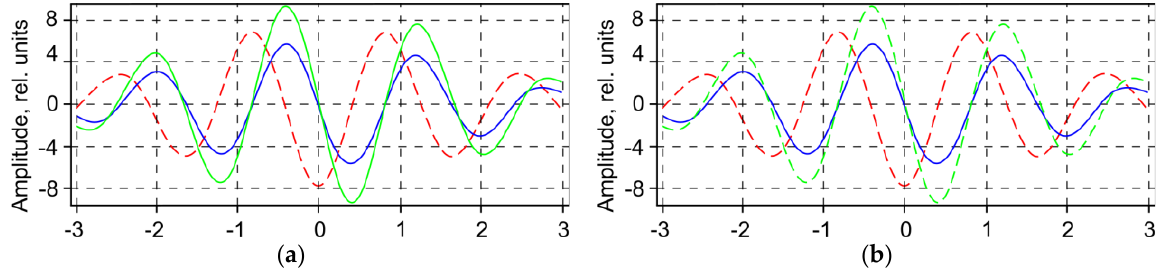
Figure 3. The amplitude functions of the real (solid line) and imaginary (dashed line) parts of the components: ( a ) linear polarization at incidence angles of +45 ◦ and − 45 ◦ ; ( b ) circular right- and left-handed polarizations (focused electric field components: X—red; Y—green; and Z—blue). The analysis shows that the Z-component has a dramatic effect on the formation of linear diffraction gratings on the surface of a multilayer structure based on chalcogenide glass semiconductors As 2 S 3 and a-Se. Coincidence or displacement of the grating for the longitudinal component with respect to the grating in other components determines the height of the reliefs formed on the surface of